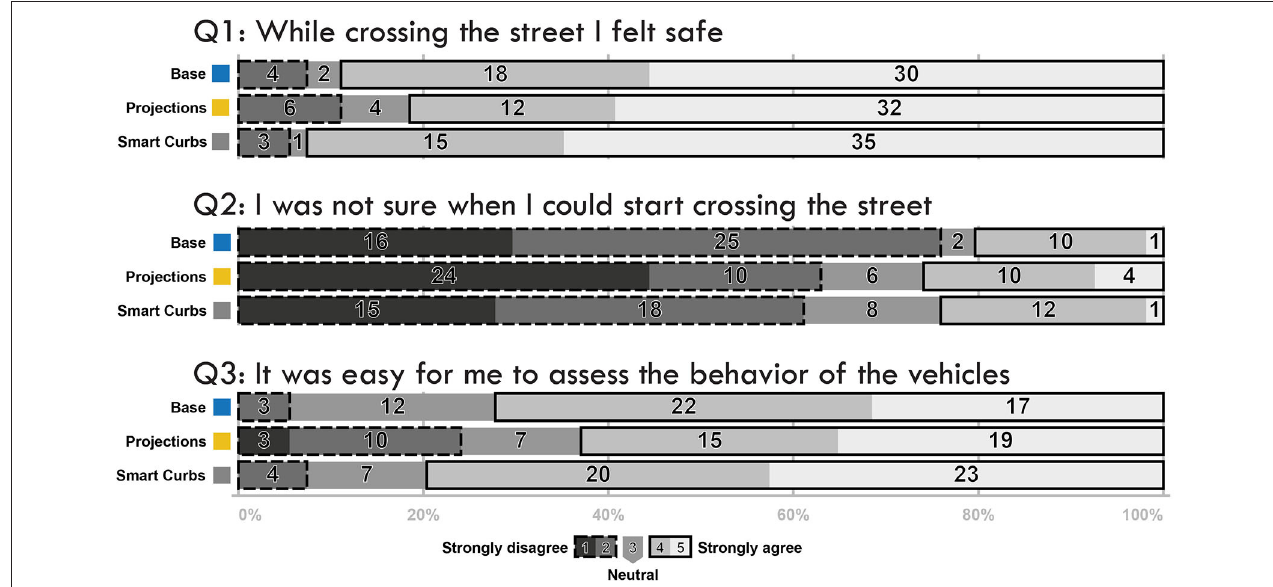
FIGURE 6 | Results of the Likert-Scale questionnaire on the subjective feeling of safety, showing the frequency of answers collectively across all runs (i.e., in total 54 answers per concept and question). Bar chart with frequency of 52 answers from Likert-Scale questions. Q1Base: strongly disagree: 4; agree: 2; neutral 18; agree: 30. Q1Projections: strongly disagree: 6; agree: 4; neutral 12; agree: 32. Q1Smart Curbs: strongly disagree: 4; agree: 2; neutral 18; agree: 30. Q2Base: strongly disagree: 18; agree: 25; neutral 2; agree: 10; strongly agree: 1. Q2Projections: strongly disagree: 24; agree: 10; neutral 6; agree: 10; strongly agree: 4. Q2Smart